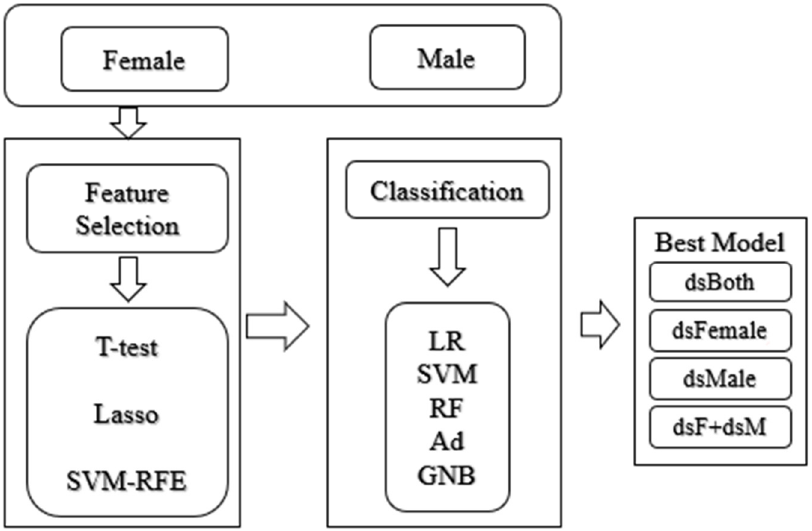
Figure 1. Experimental workflow of this study. Three feature selection algorithms were evaluated for their binary classification performances using five classifiers on the datasets with both sexes. The three feature selection methods were Ttest, least absolute shrinkage and selection operator (LASSO) and support vector machine (SVM)-based recursive feature elimination (SVM-RFE). The five classifiers were Logistic Regression (LR), Support Vector Machine (SVM), Random Forest (RF), AdaBoost (Ad) and Gaussian Naïve Bayesian (GNB).